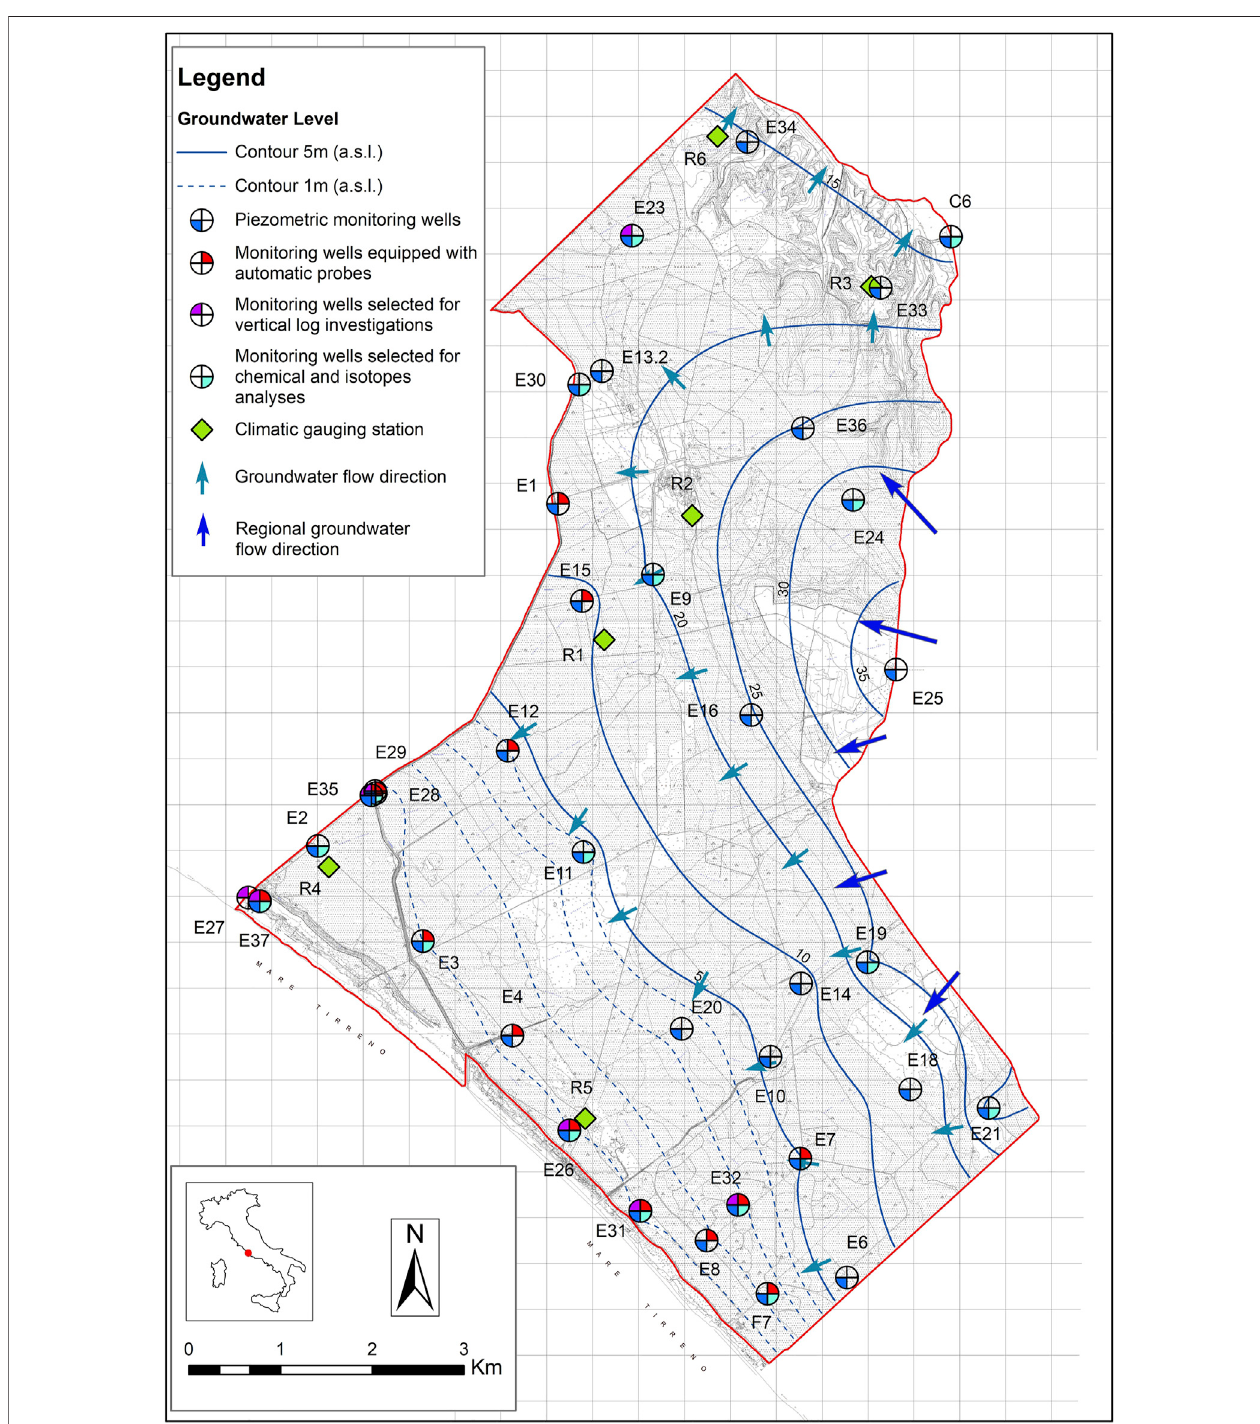
FIGURE2| Location mapofthegroundwatermonitoringnetwork(E#)andclimategaugingstations(R#);piezometricsurfacereferredtoinautumn2020(lightblue lines) and main groundwater fl ow directions (light blue and blue arrows).